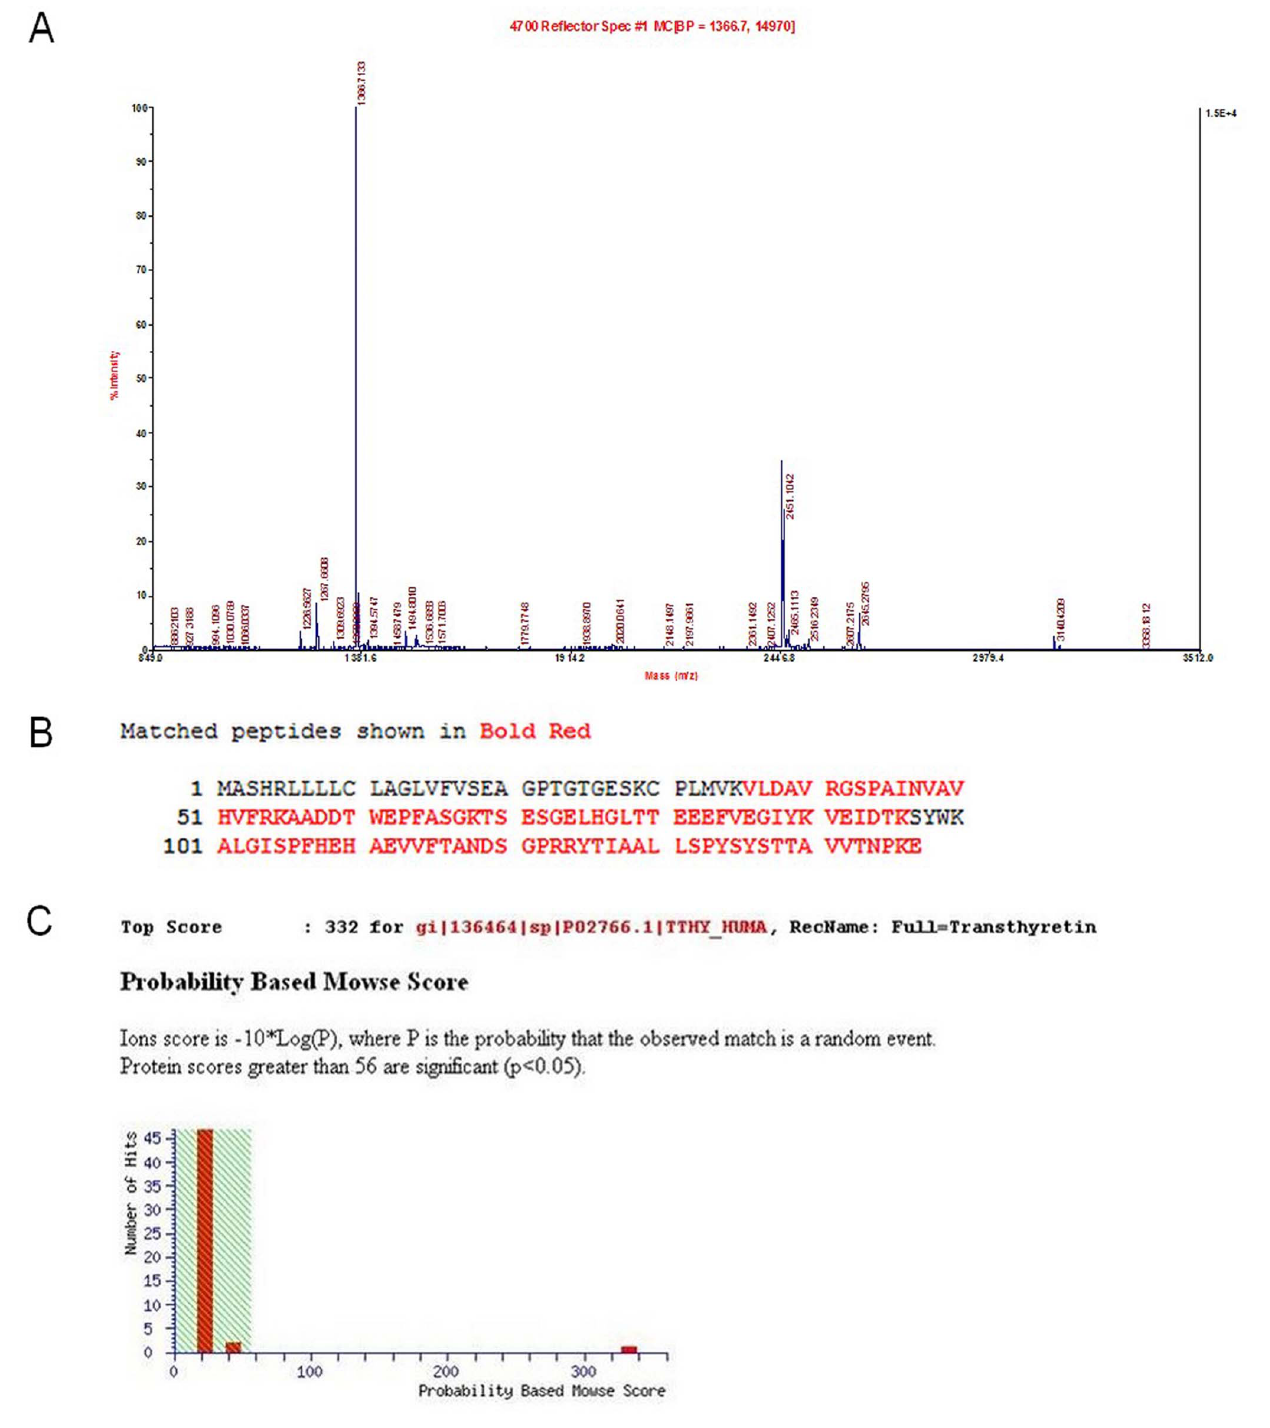
Figure 3. Representative mass spectrometry output and identification of spot No. 3. ( A) The peptide mass fingerprint of spot 3 from human serum analyzed with MALDI-MS. (B) Identification of spot 3 as transthyretin with 73% amino acid sequence coverage by matched peptides using MASCOT software. (C) MASCOT search of the protein in the NCBI database. doi:10.1371/journal.pone.0095345.g003 2, 3, 4, 7 and 8 (Table 2). Enlarged regions of the respective gels are shown in Figure 2 (Figure 2).